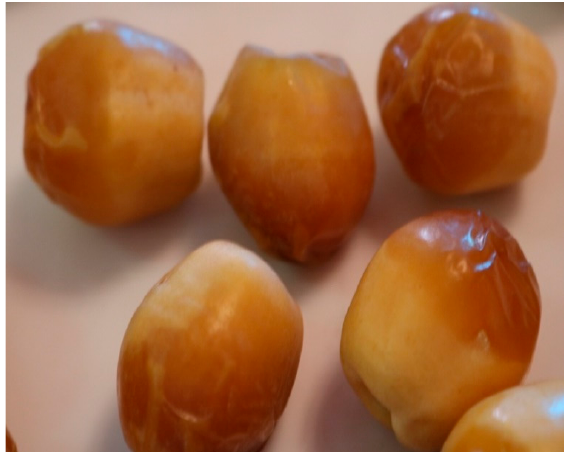
Figure 29. Sample of Al-hilalia dates.